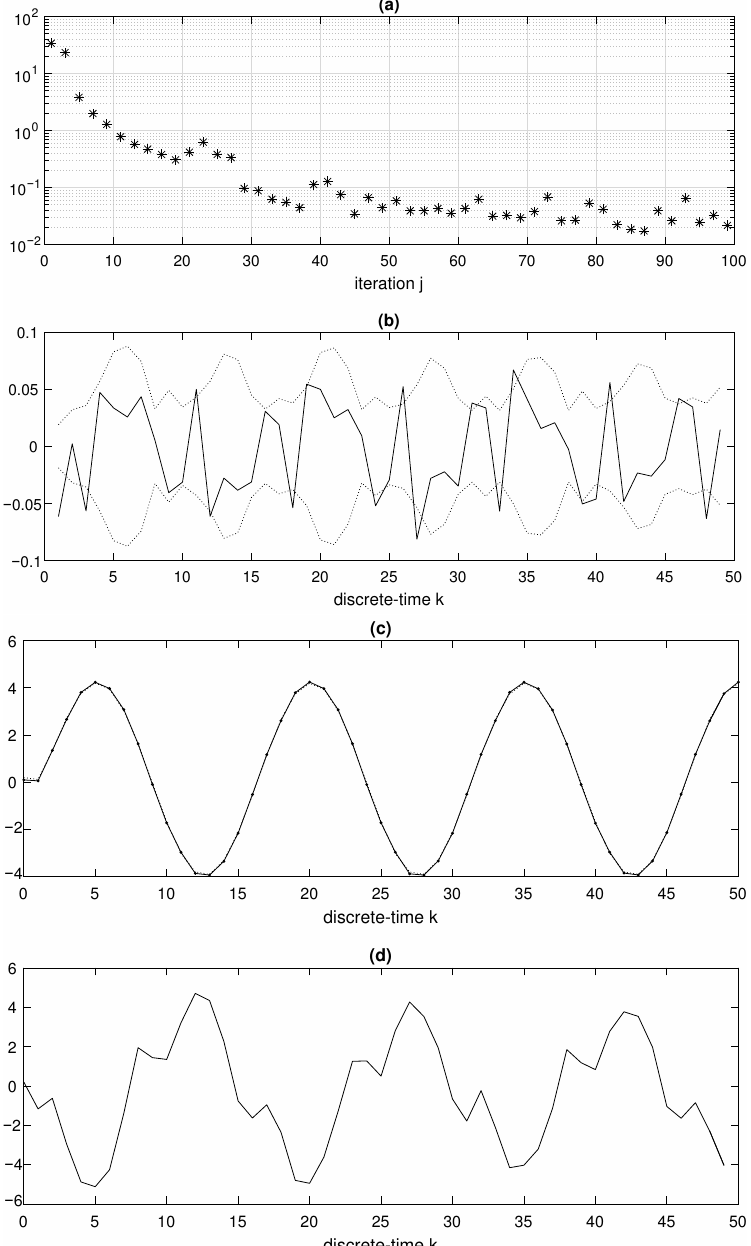
( k ) | ( ∗ ) versus iteration j . ( b ) e 100 ( k ) (solid line) and φ 100 ( k ) , − φ 100 ( k ) Figure 2. ( a ) max k ∈{ 1, ··· ,50 } | e j φ (dotted lines) versus discrete-time k . ( c ) y 100 ( k ) (solid line) and y 100 time k . ( d ) u 100 ( k ) versus discrete-time k